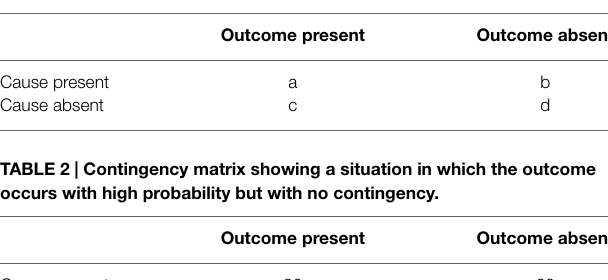
TABLE 1 | Contingency matrix showing the four different types of trials as a function of whether or not the cause and the outcome are present.